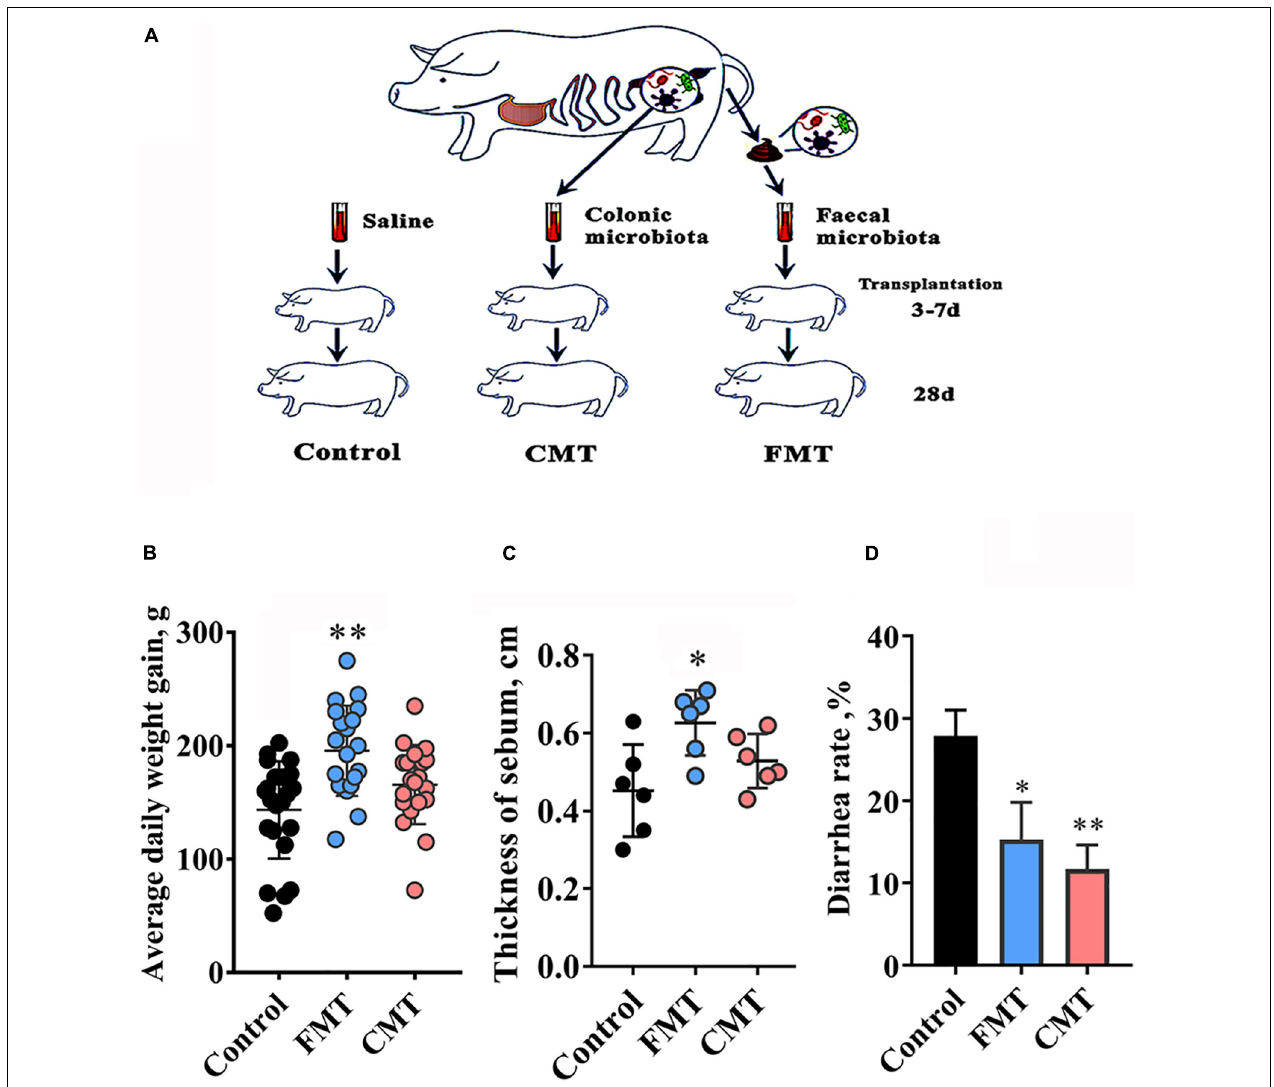
FIGURE 1 | Microbiota transplantation improved growth performance of recipient piglets. (A) Schematic of the experimental design. (B) The average daily gain of piglets from day 7 to day 28; control group, n = 23; FMT group, n = 22; CMT group, n = 21; (C) Neck subcutaneous fat thickness in piglets on day 28 ( n = 6). (D) Diarrhea rate of piglets during the experiment. CMT, colonic microbiota transplantation; FMT, fecal microbiota transplantation. The data are presented as the mean ± S.D. ∗∗ Indicates P < 0.01, and ∗ indicates P < 0.05 compared with the